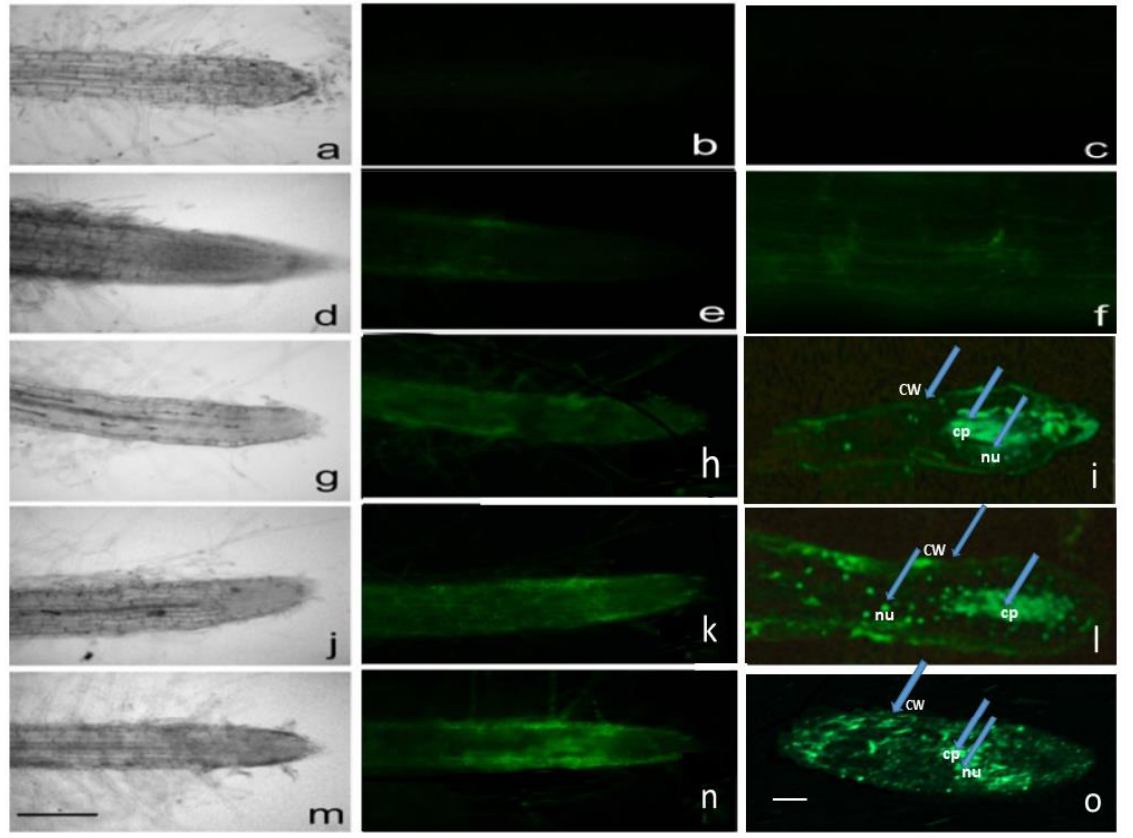
Figure 2. Visualization of FITC-labeled Gly and dipeptides in tobacco seedling roots. ( a – c ) Control roots. ( d – f ) Roots incubated with FITC. ( g – i ) Roots incubated with FITC-Gly. ( j – l ) Roots incubated with FITC-GlyGly. ( m – o ) Roots incubated with FITC-GlyAsp. Scale = 200 µm. ( c , f , i , l , o ) Semi-thin root sections. Arrows point to cw — cell wall; cp — cytoplasm, nu — nuclei.